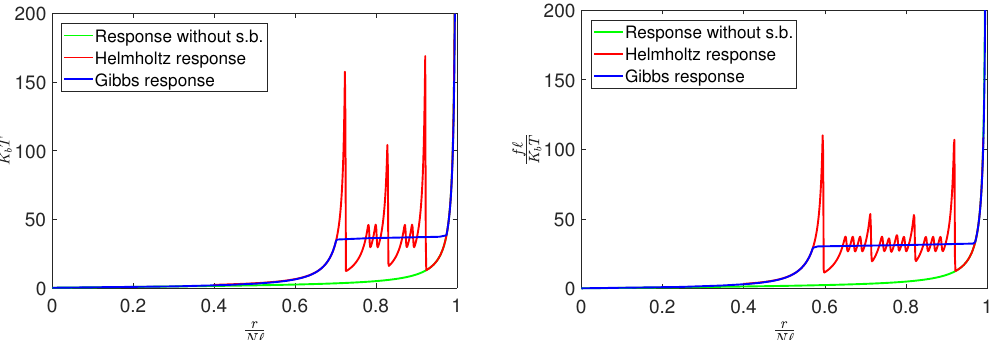
Figure 6. Force–extension response of two chains with s = 3 (left panel) and s = 4 (right panel) and different heterogeneous distributions of sacrificial bonds under both Gibbs (blue curves) and Helmholtz (red curves) conditions. We also added the response of the same system without sacrificial bonds in order to compare the different behaviors (green curves). On the left panel, we assumed n k = 3 + k ∀ k and E k / ( K b T ) = 35 n k ∀ k , while on the right panel, we adopted n k = 3 + k ∀ k and E k / ( K b T ) = 30 n k ∀ k . The plots are represented with adimensional quantities. The other parameters are given by N = 50, h / k = 1, and d / (cid:96) =